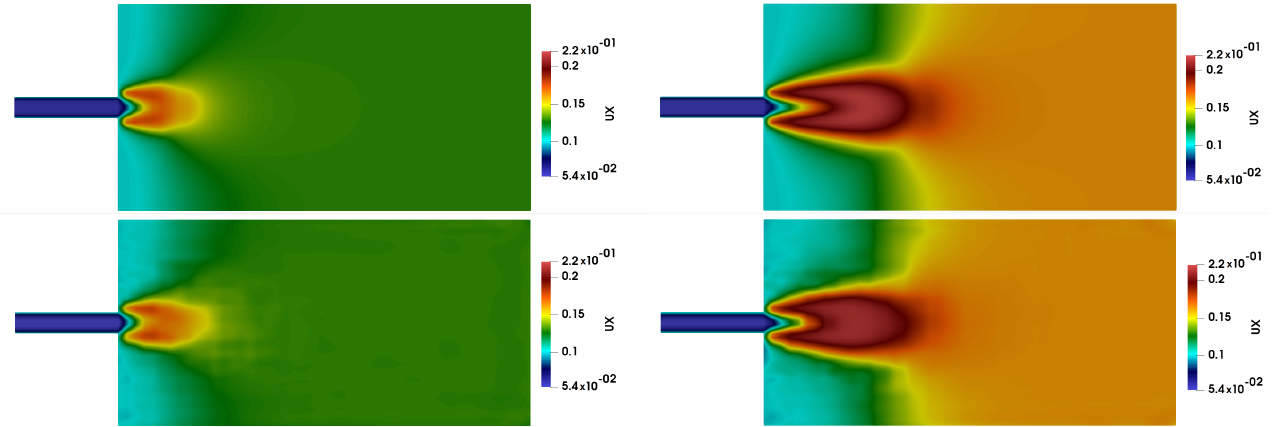
Figure 8. (Classical VAE) On the top, the high-fidelity first component of the velocity fields for the two time steps 499 and 998. On the bottom, the decoder outputs for the two time steps 499 and 998 at the final 4000-th epoch of the training